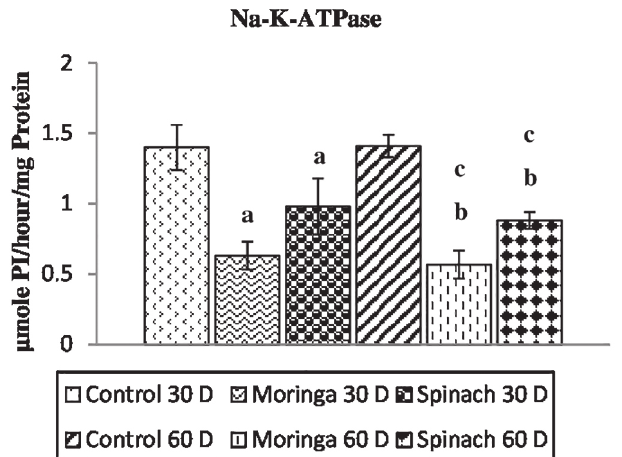
FIGURE 5 - (Na+-K+)-ATPase activity of selected plant foods trea ted animals for 30 days and 60 days respectevely. Each bar denotes mean±SD of three pooled samples. Each pool contained a mixture of three thyroi glands isolatred from three individual rats. One-way analysis of variance (ANOVA) test followed by Tukey’s post hoc test was done to determine differences across means of different groups. Mean values are significantly different by ANOVA at p<0.05. a Control 30 days versus treated 30 days group; b Control 60 days versus treated 60 days group; c Treated 30 days versus treated 60 days